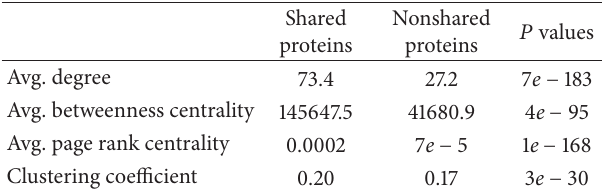
Table 1: Network properties of shared and nonshared